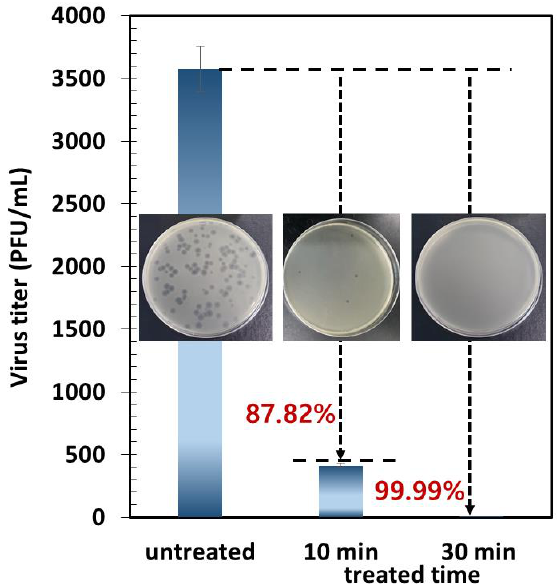
Figure 8. Electrothermal antiviral activity of the carbon surface against the MS2 bacteriophage via a plaque assay (inset photos: plaque assay results).